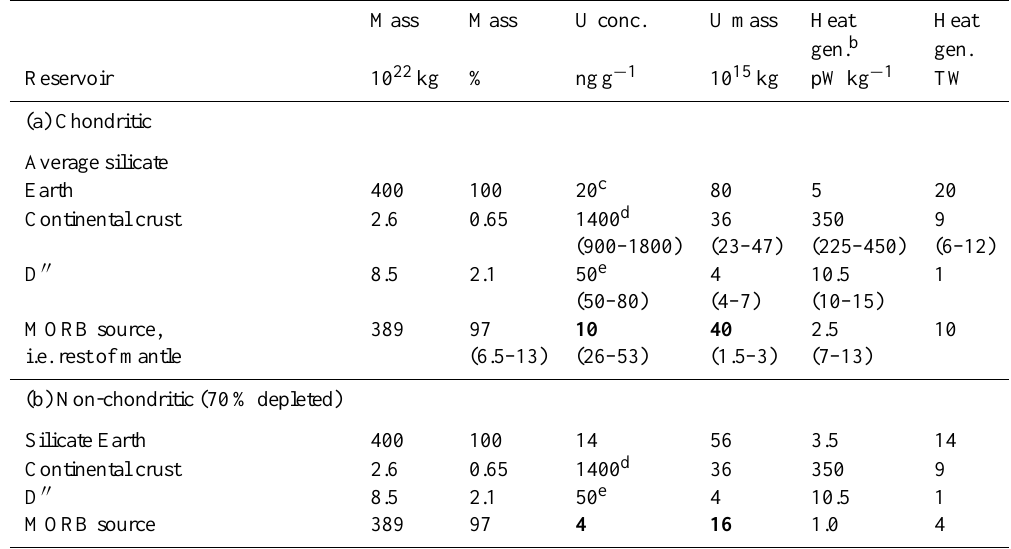
Table 5. Uranium and heat generation budgets a .